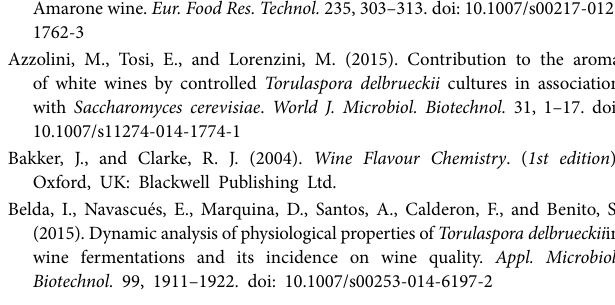
Supplementary Figure S1 | Accumulated production of CO 2 during pure and mixed culture fermentations. TD1/SC1, TD2/SC1, TD1/SC2, TD2/SC2: sequential inoculation with Torulaspora delbrueckii (TD1, TD2) followed by Saccharomyces cerevisiae (SC1, SC2) after 48 h; SC1 and SC2: